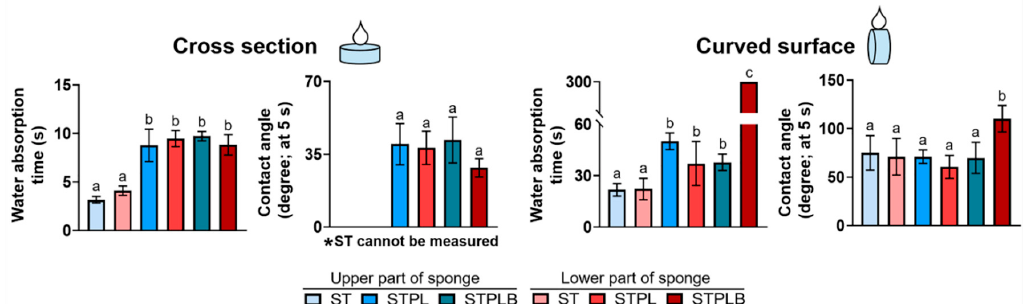
Figure 6. Water absorption time and contact angles at the cross sections or curved surfaces of the gelatin sponges prepared using the different molds. ST: silicon tube showing high permeability; STPL: ST covered with PVDC at the lateral side; STPLB: ST covered with PVDC at the lateral and bottom sides. Same alphabet: no statistical significance. Mean with SD ( n = 4, p < 0.05, one-way ANOVA with Tukey–Kramer tests).